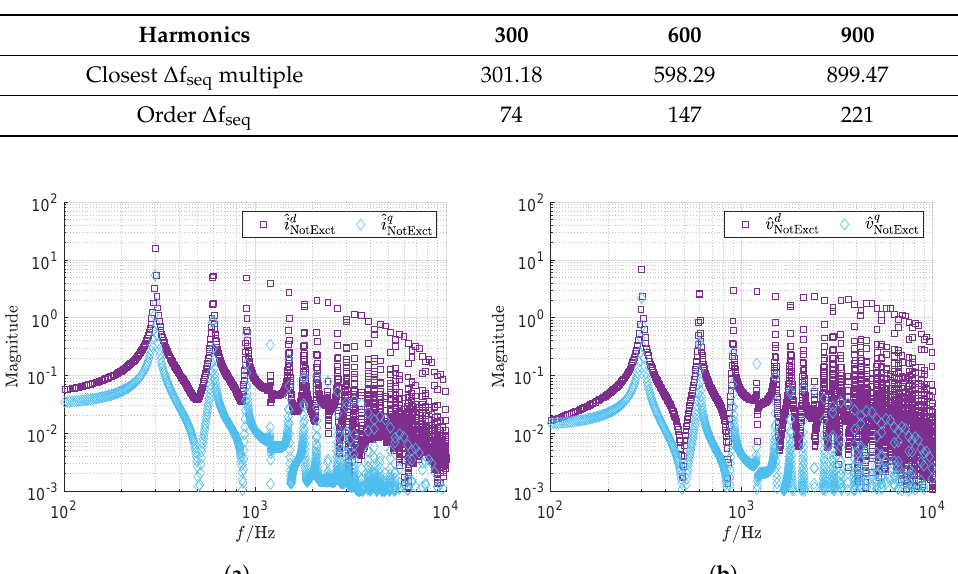
Table 2. Harmonics and corresponding closest multiples of the excitation sequence.